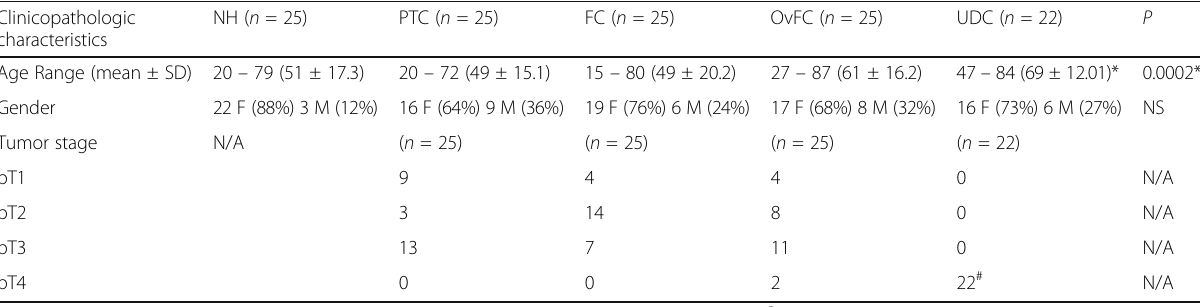
Table 2 Clinicopathologic characteristics of the study groups Clinicopathologic